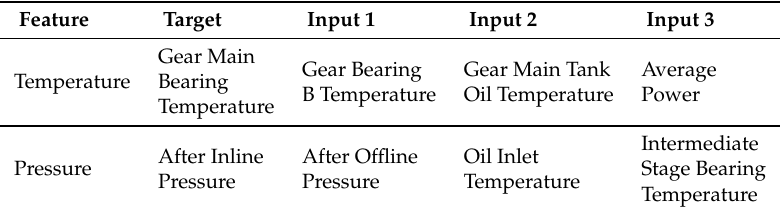
Table 2. Table shows the corresponding features selected using univariate statistics for the two different target